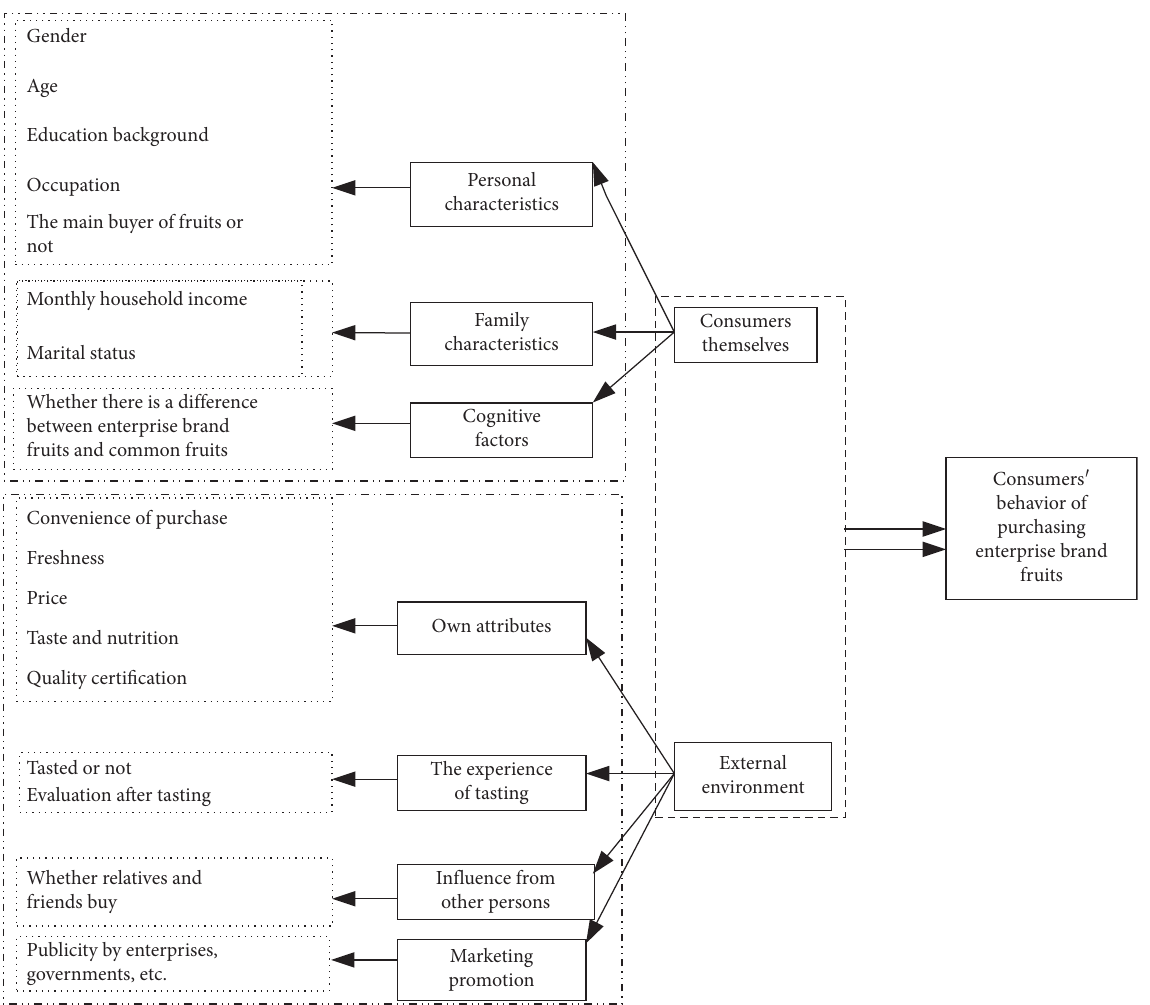
Figure 1: Theoretical framework of the factors influencing the behavior of purchasing enterprise brand